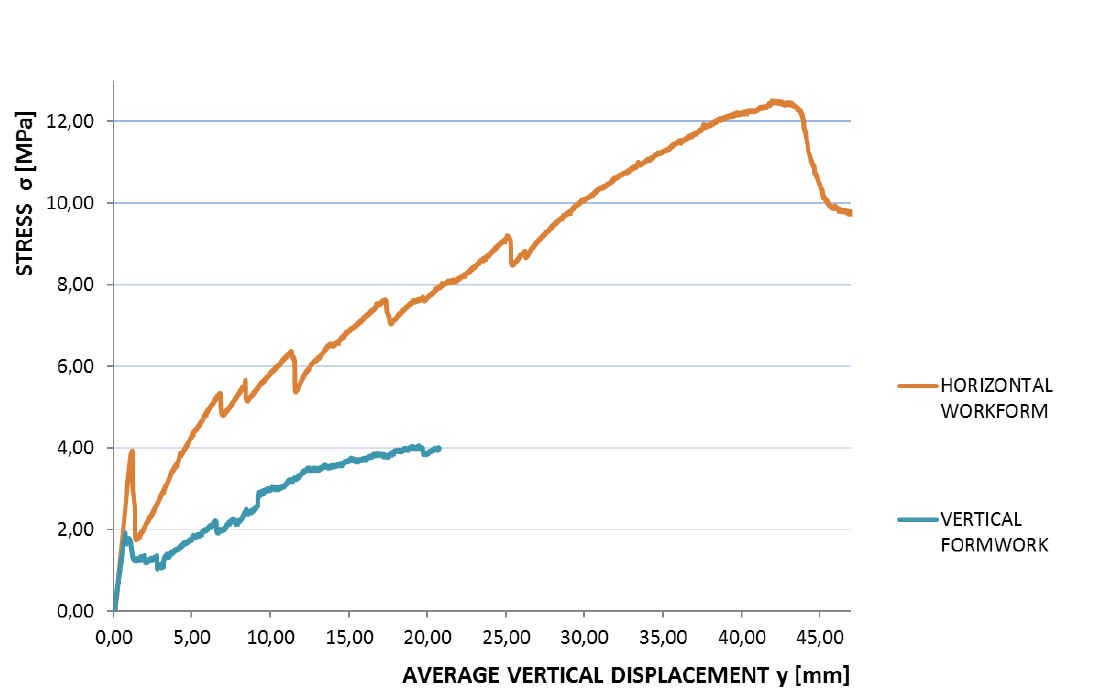
Figure 7. The flexural testing of TRLC slabs with 3D glass